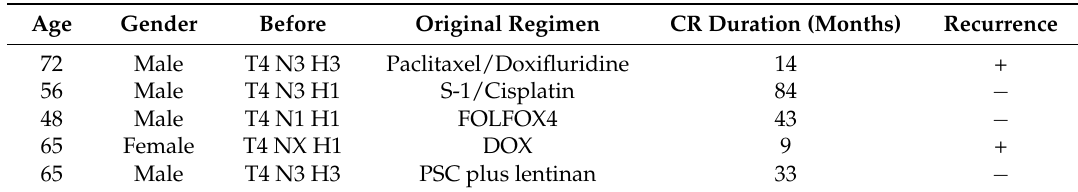
Table 3. Patients with liver metastases showing complete response in the